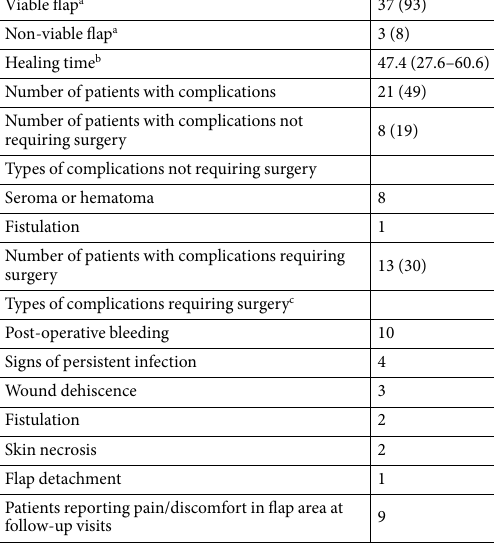
Table 3. Flap outcome and complications. a The calculation of percentage is done by using 40 patients as three patients died within 30 days of the flap surgery. b The time between flap surgery and the last day of antibiotic treatment, calculated on the group with viable flaps. c One patient could have several complications contributing to the decision of re-operation.